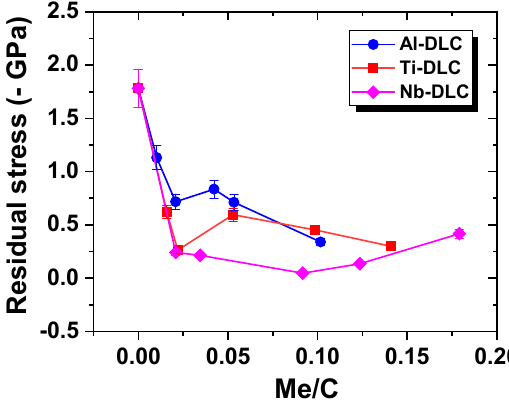
Figure 9. Evolution of the mechanical stress in the Me-DLC films as a function of Me/C ratio.